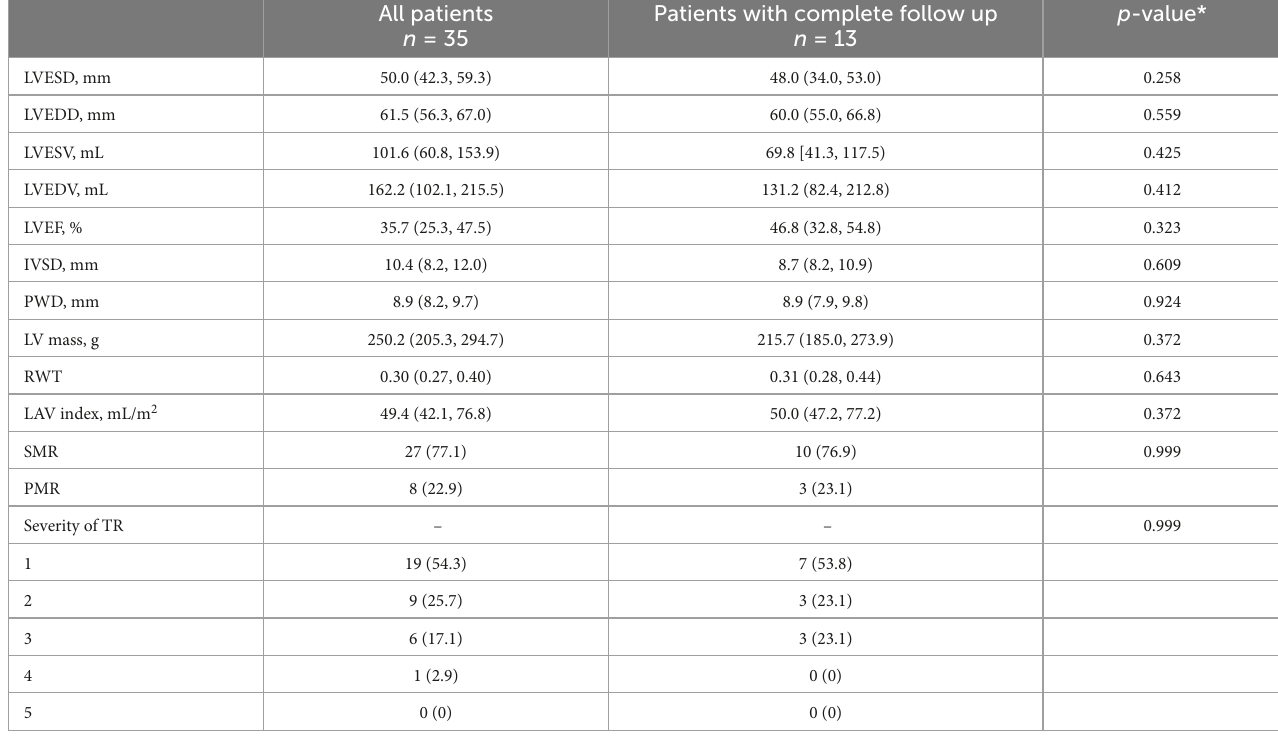
TABLE 2 Baseline echocardiographic data.